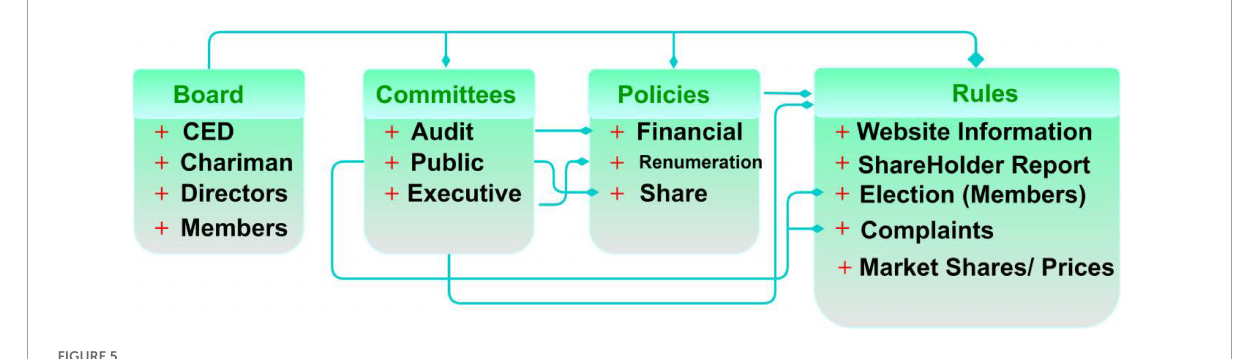
FIGURE5 Classification of “hotel and tourism” industry.